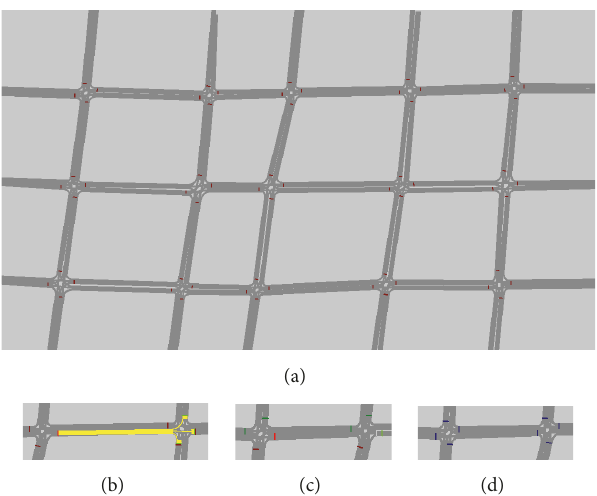
Figure 8: Topology and settings of simulation traffic network. (a) The topology of simulation traffic network; (b) route decisions setting; (c) travel time sections setting; (d) queue Counters